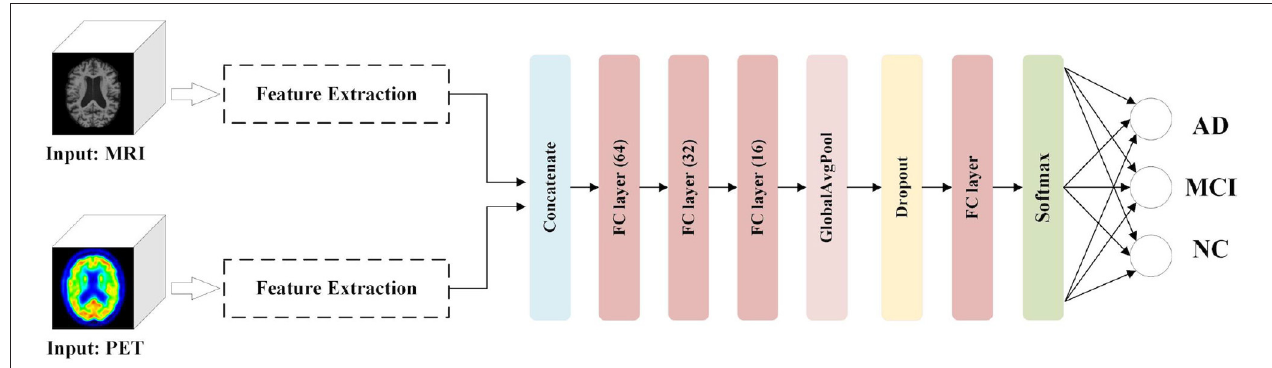
FIGURE 5 | AD diagnostic framework with multimodal feature fusion method.